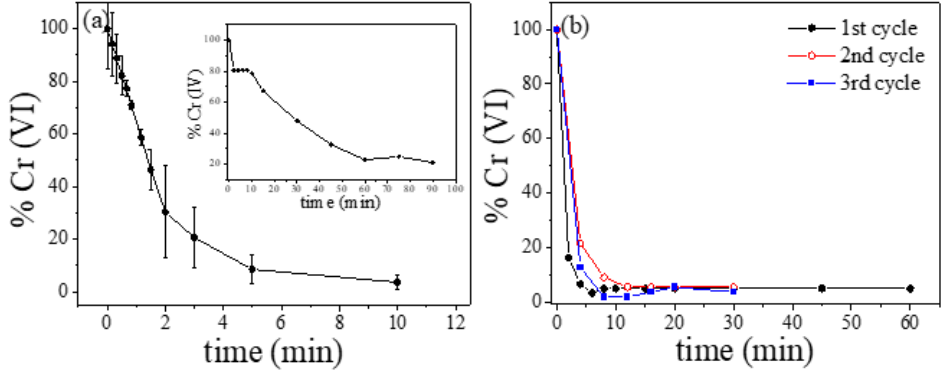
Figure 8. ( a ) Cr (VI) adsorption (% Cr (VI)) in the presence of the selected annealed sample. Inset: initial citric acid-coated MNPs. ( b ) Reusability adsorption tests (adsorption curves after 3 subsequent cycles).